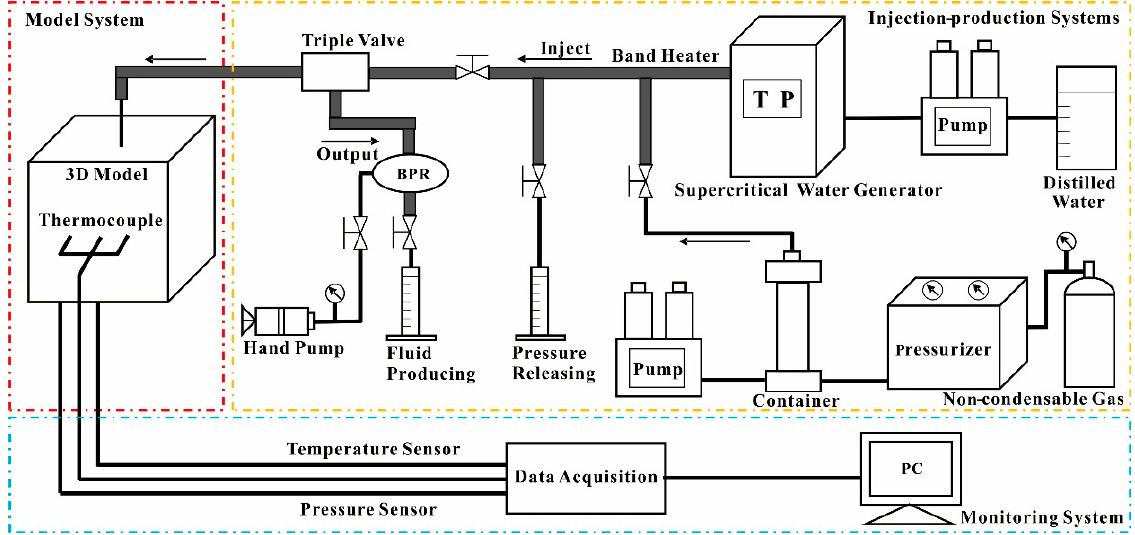
Figure 1. Flow diagram of three-dimensional physical simulation experiment.